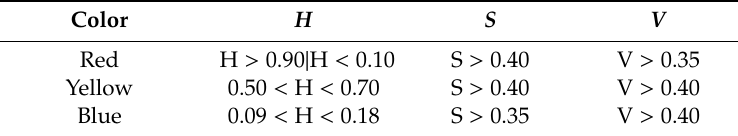
5 of 22 Figure 3. The color space threshold segmentation step diagram.